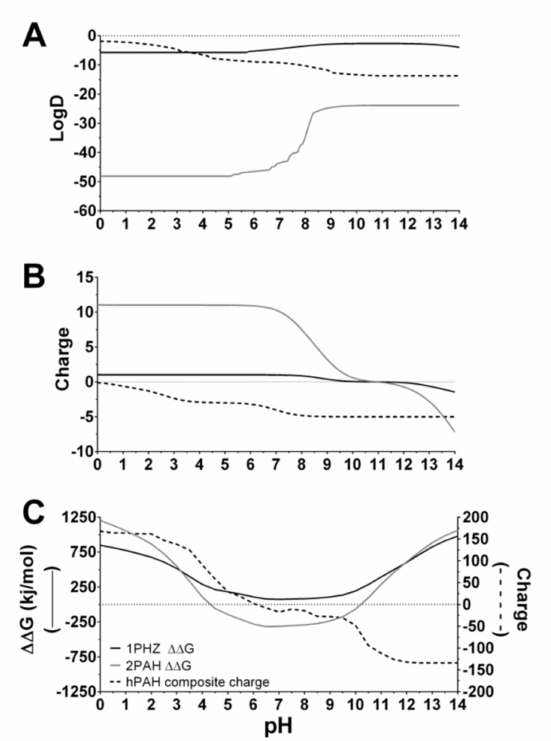
Figure 2. In silico prediction of the pH-dependent characteristics of nanoparticle constituents. ( A ) Dis- tribution coefficient (logD) and ( B ) total charge of glucosamine (—), tripolyphosphate (TPP) (–) and chitosan (CS) oligomer (—) used to generate the extended polymeric chains with a deacetylation degree (DD) of 91.8%. ( C ) Free energy of human phenylalanine hydroxylase (hPAH) folding obtained from the pdb files used to generate the full-length composite—1PHZ (—) and 2PAH (—); Total charge of the full-length hPAH composite (–). For further details see Materials and